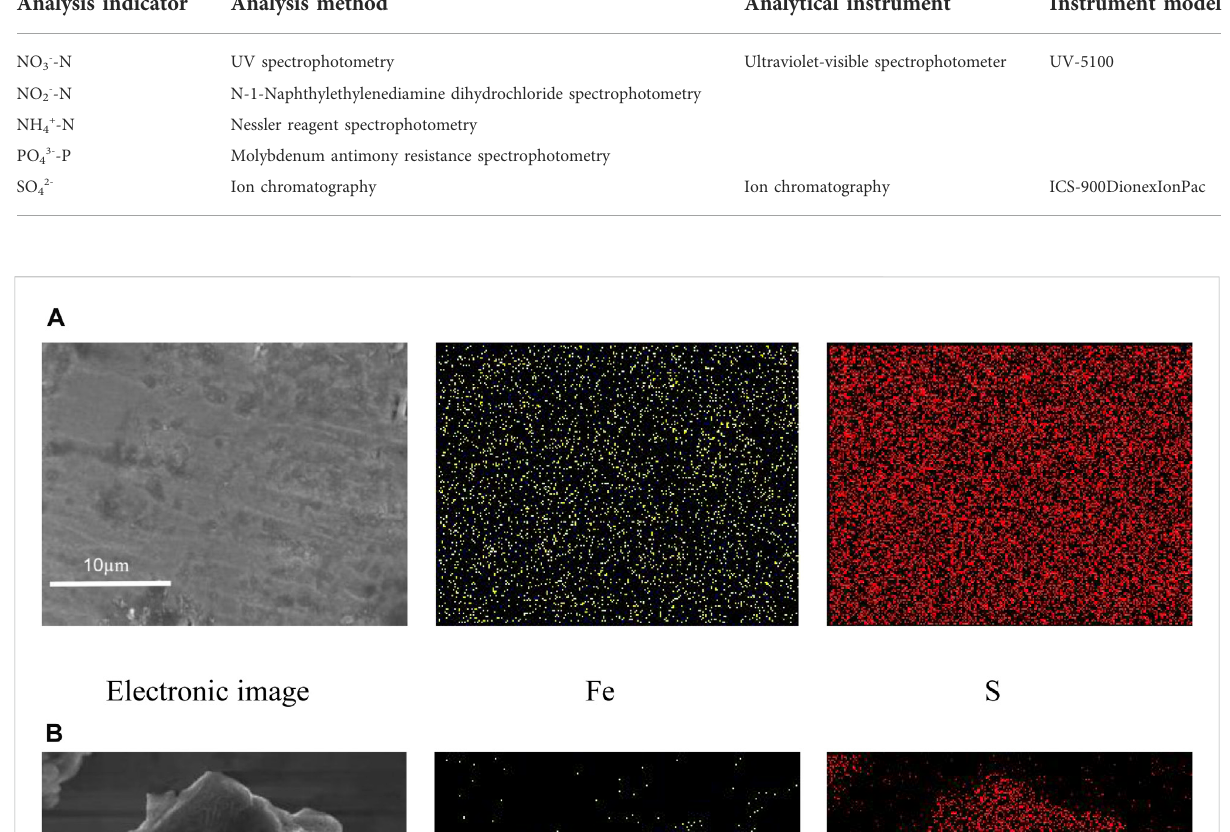
FIGURE 1 SEM images and elemental mappings of pyrite (A) , pyrite tailings (B) , and magnetite tailings (C) .